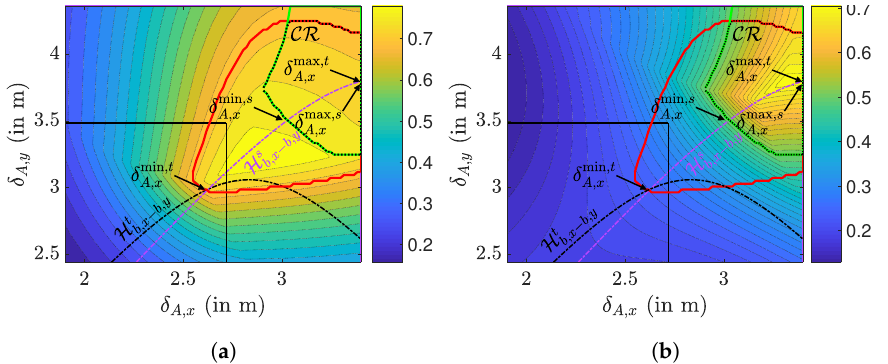
Figure 9. Uniformity distribution for X max = 17 m, K S = 1.3, K A = 6/4, Z max = 2 m and m S = 1. ( a ) U t and ( b ) U s